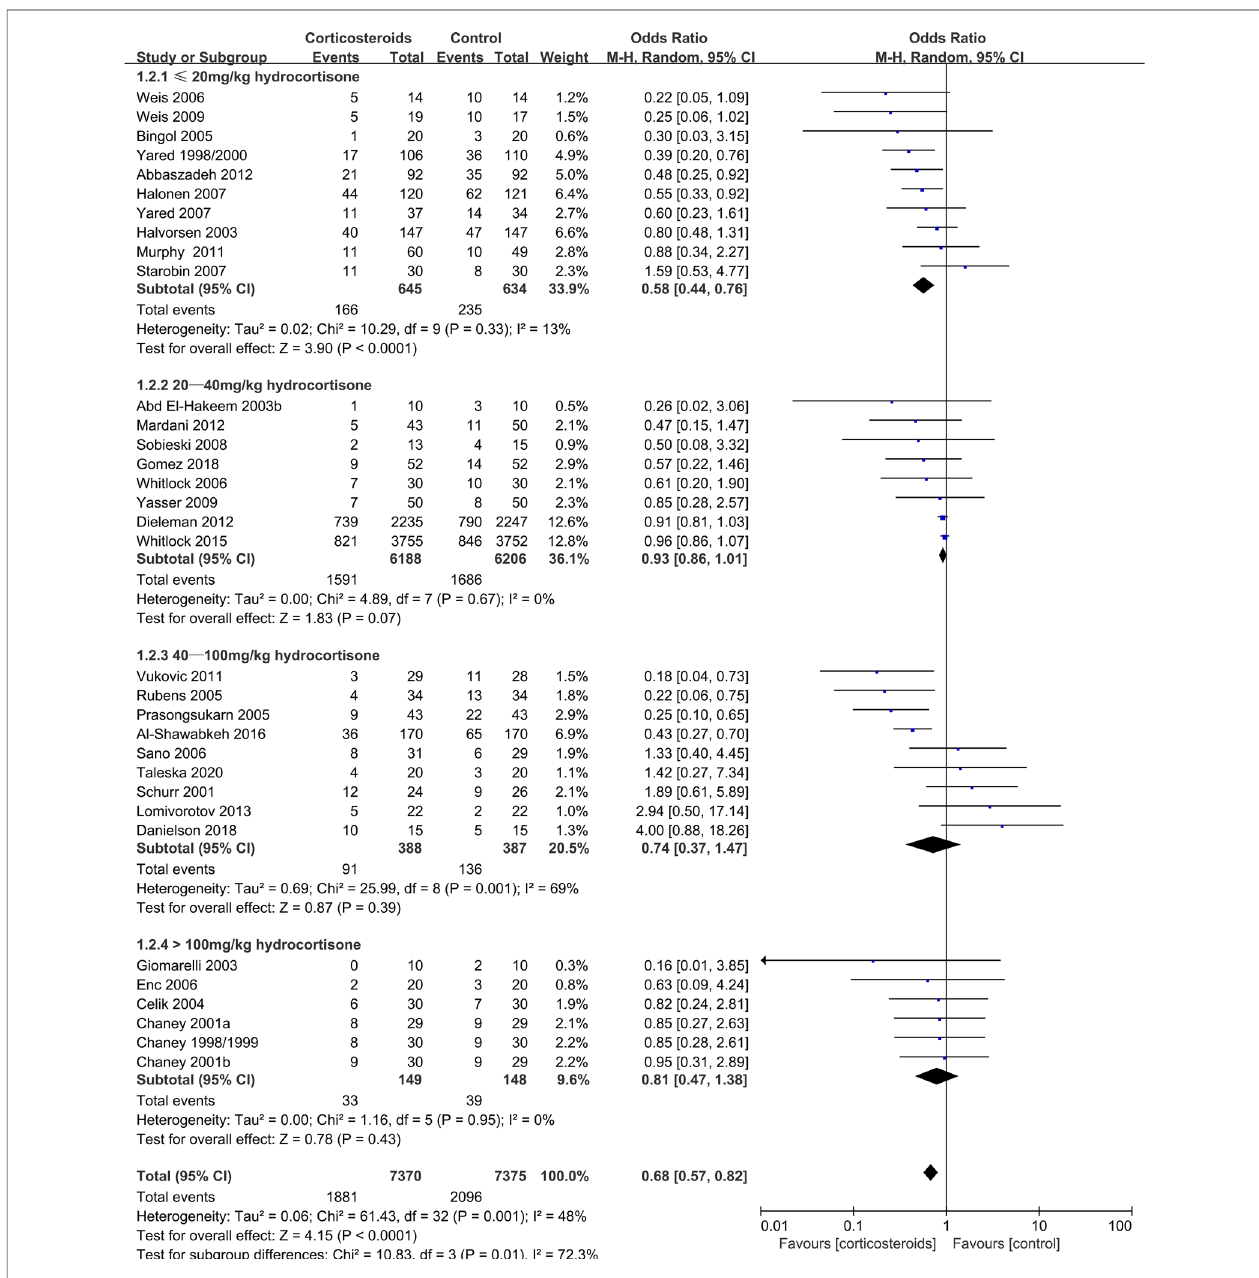
FIGURE 4 | Impact of corticosteroids on postoperative new atrial fi brillation